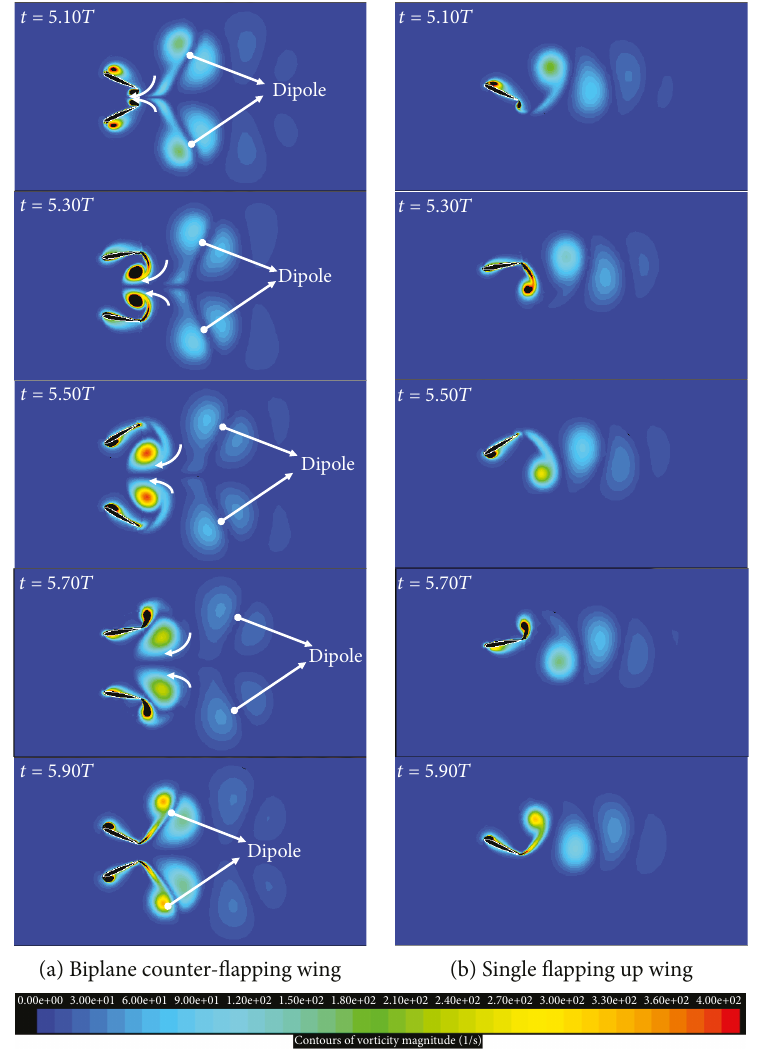
Figure 8: The vortex contours of the biplane counter- fl apping wing and single fl apping up wing during a fl apping